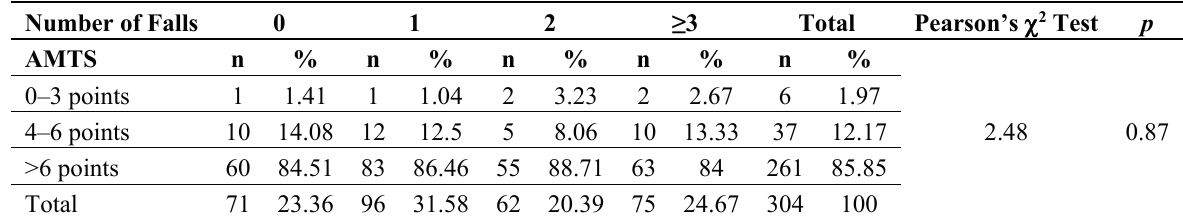
Table 4. The correlation between the number of falls and the results of the AMTS (Pearson’s correlation coefficient).